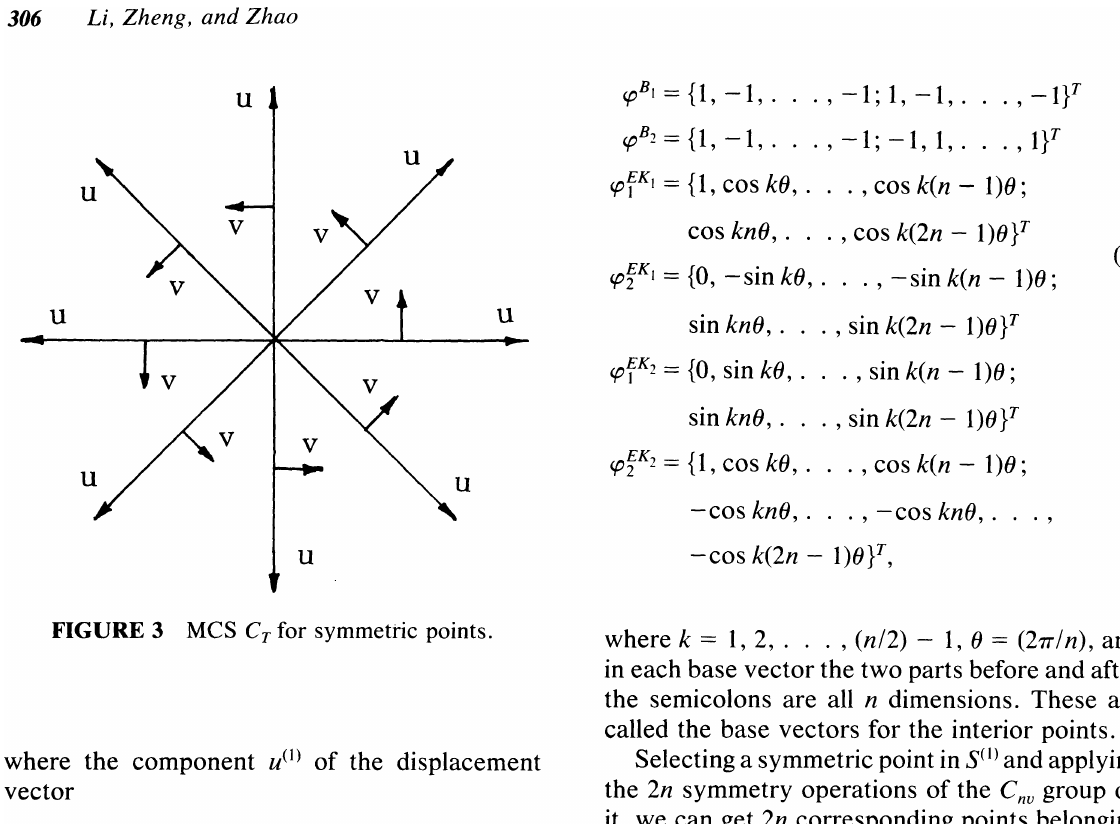
FIGURE 3 MCS Cr for symmetric